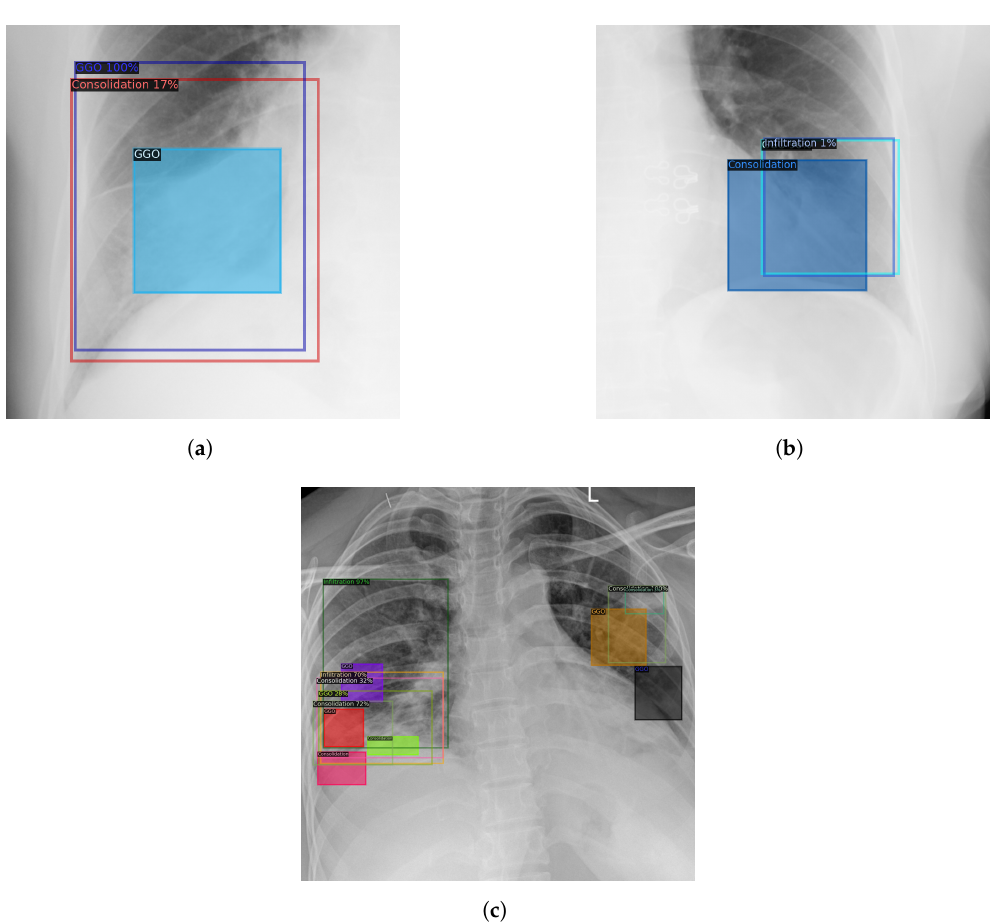
Figure 15. Incorrect detection but still be useful as the warning. ( a ) Larger detection. ( b ) Incorrect type detection. ( c ) Prediction